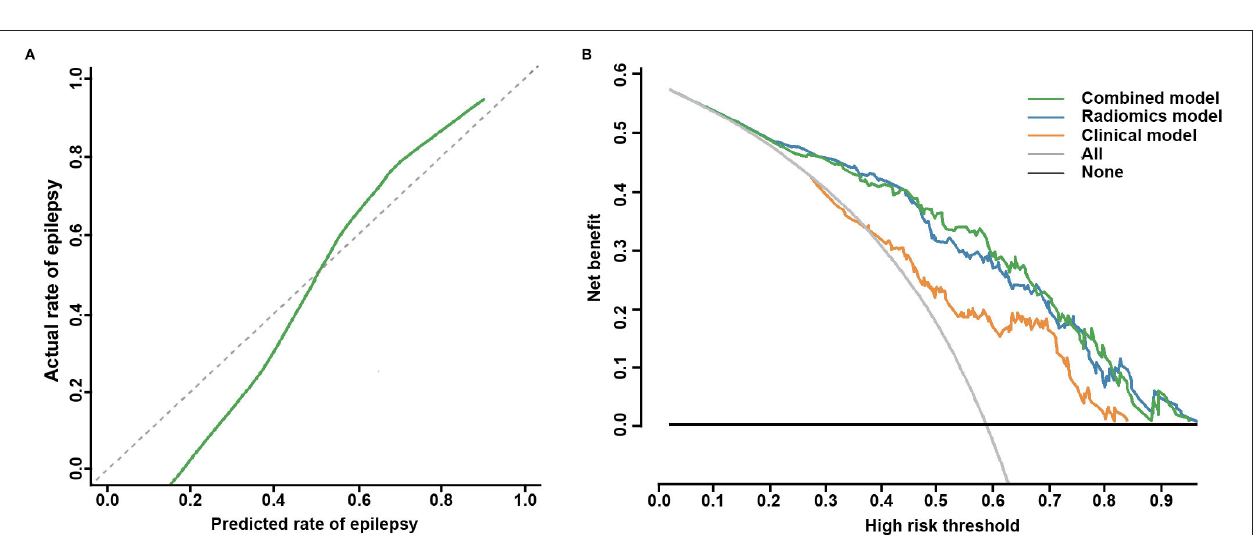
management of epilepsy (25–27). Therefore, patients with